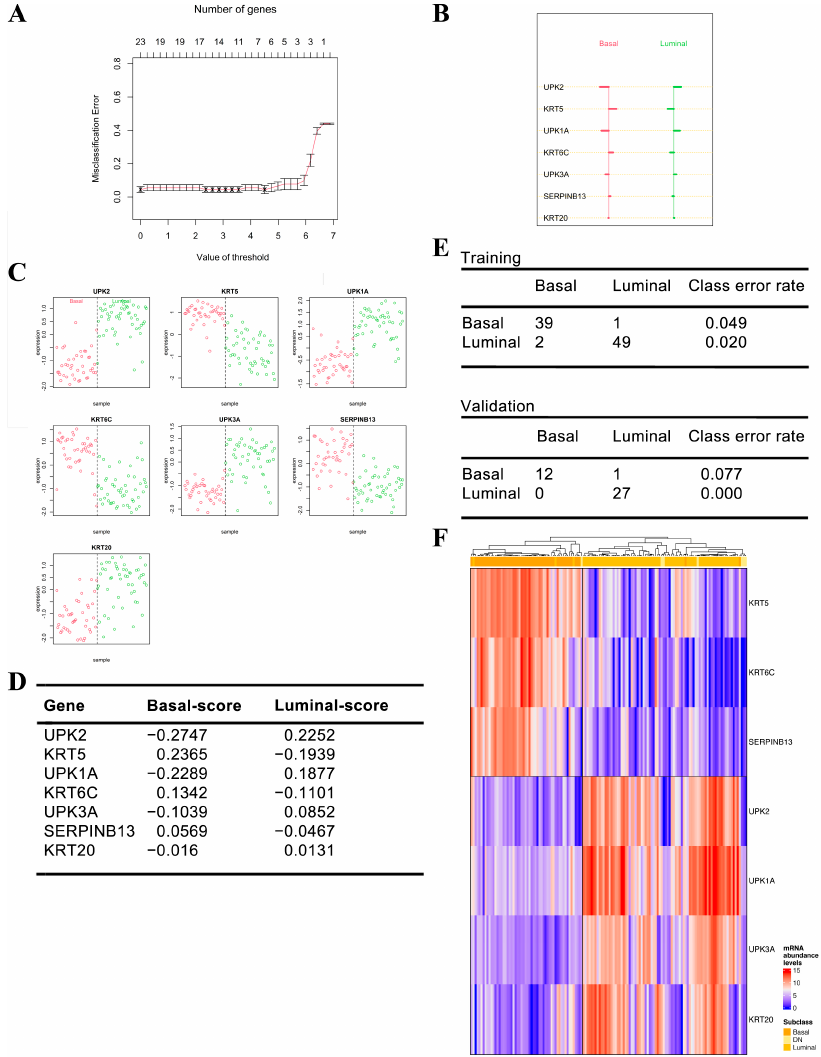
Figure 4. Nearest shrunken centroids classification. ( A ) Illustration of training the PAMR prediction profile within the training dataset. At threshold 4.51, the misclassification error rate was minimal, resulting in seven genes being selected for the classifier (KRT5, UPK2, KRT6C, UPK1A, SERPINB13, UPK3A, KRT20); ( B ) visualization of the shrunken class centroids, i.e., the distance of each gene to the nearest shrunken centroid for each subtype; ( C ) dot plot of the relationship between gene expression and MIBC subtype classification for each tumor in the training dataset. Each point represents a unique tumor and the color represents the MIBC subtype that the PAM classifier classified these tumors into; ( D ) PAMR scores for each gene in the seven-gene MIBC molecular classifier; ( E ) confusion matrix for predicted subtype vs. immunohistochemical subtype. The overall misclassification error rate was 3.3% in the training dataset and 2.5% in the testing dataset; ( F ) unsupervised hierarchical clustering (Pearson correlation) of normalized abundance levels of the seven genes selected for the PAM classifier in the total cohort of 138 tumors.